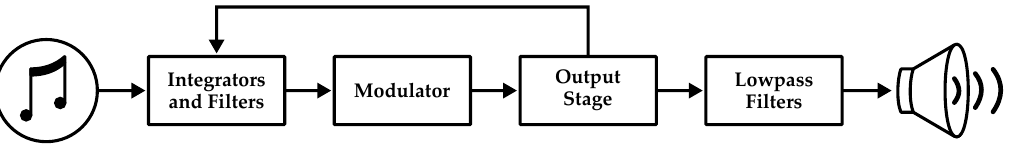
Figure 16. Block diagram of the driving chain for a MEMS speaker.